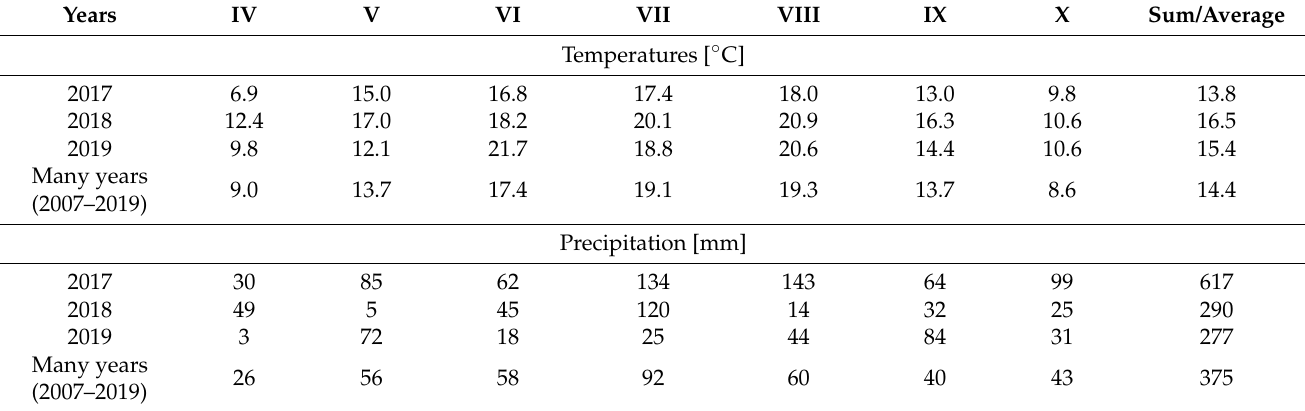
Table 7. Average monthly air temperatures and monthly total precipitation in individual growing